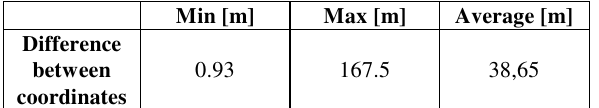
Figure 13. Camera positions measured by the GNSS device. Agisoft Photoscan Professional uses these informations as input data and, after the images alignment, it recalculates the corrected camera positions (Figure 14).